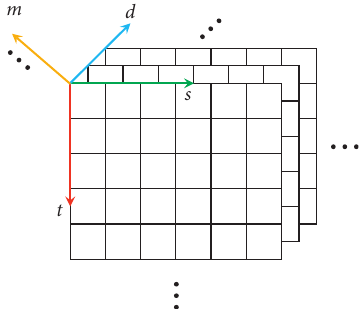
Figure 4: Structure of MRF flow volume tensor. MRF flow volume tensor consists of 4 modes, i.e., time ( t ) mode, day ( d ) mode, station ( s ) mode, and machine ( m )